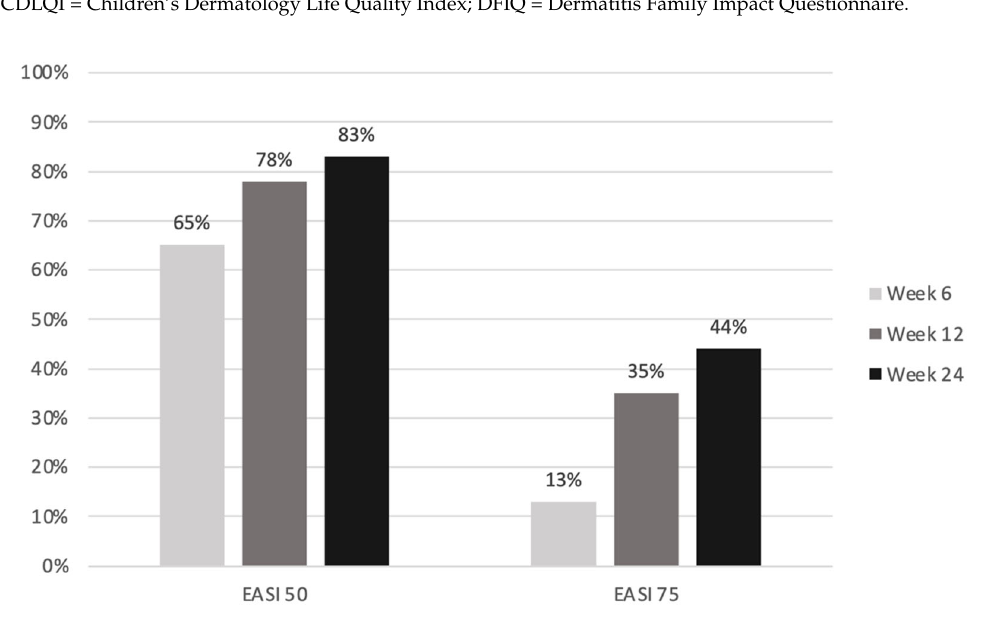
Table 3. Treatment efficacy in all patients presented as median scores (with interquartile range).